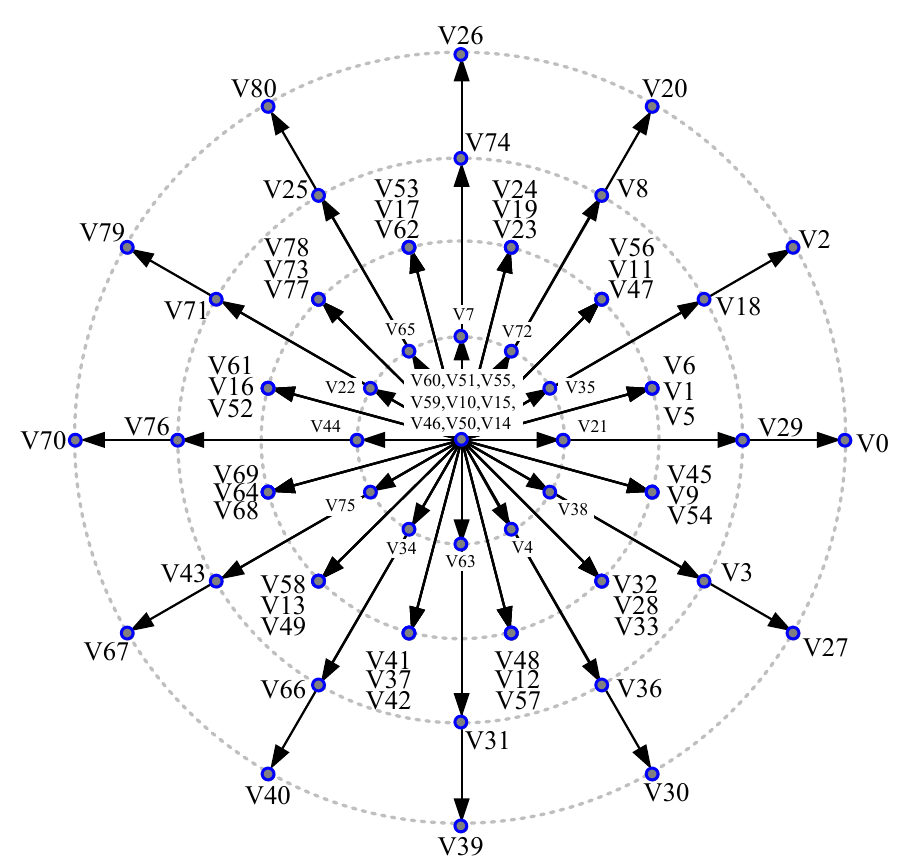
Figure 9. The space-vector diagram for S MC n switch